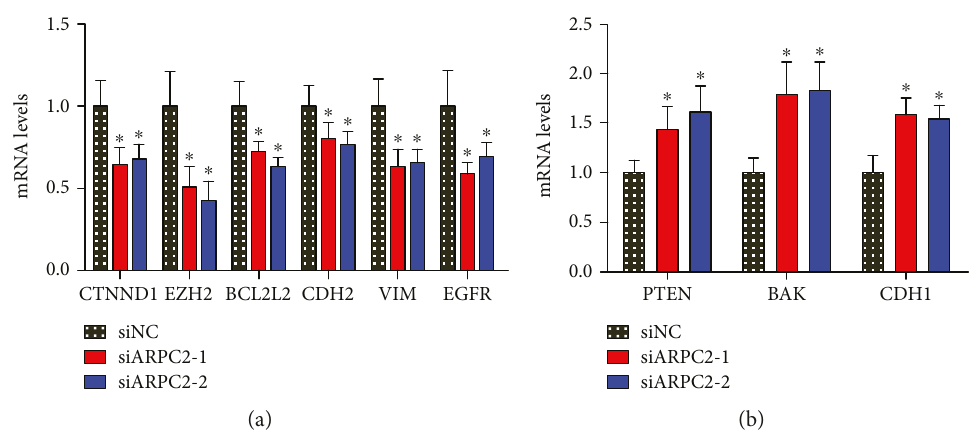
Figure 3: ARPC2 regulated proliferation and invasion-related genes. (a) mRNA levels of CTNND1, EZH2, BCL2L2, CDH2, VIM, and EGFR were decreased after transfected with ARPC2-siRNA-1 and ARPC2-siRNA-2 compared with the negative control using RT-qPCR. (b) mRNA levels of PTEN, BAK, and CDH1 were increased after transfected with ARPC2-siRNA-1 and ARPC2-siRNA-2 compared with the negative control. GAPDH was used as the endogenous control. ∗ P < 0 05 . ∗∗ P < 0 01 .